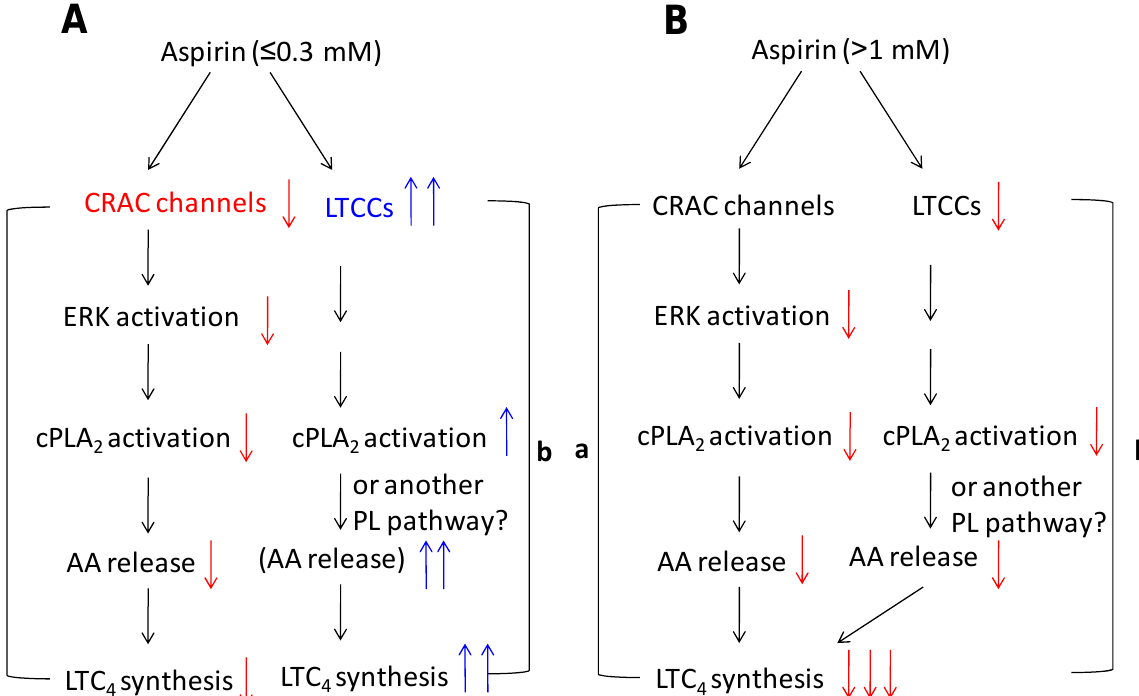
Figure 2. Dual effects of NSAIDs on the novel LTCC-mediated LTC